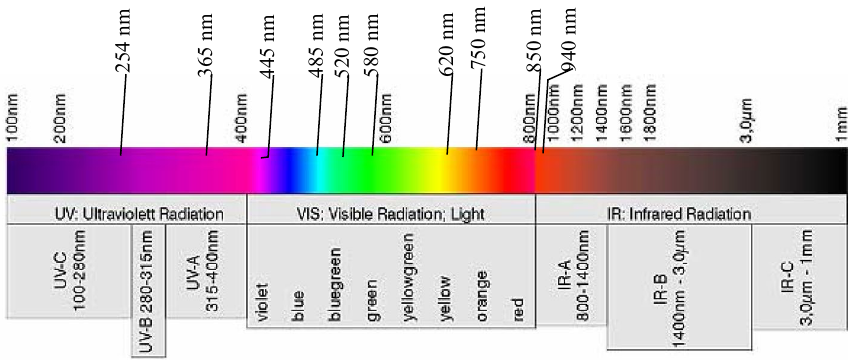
Figure 9. Spectral characteristics of the device’s light source 34